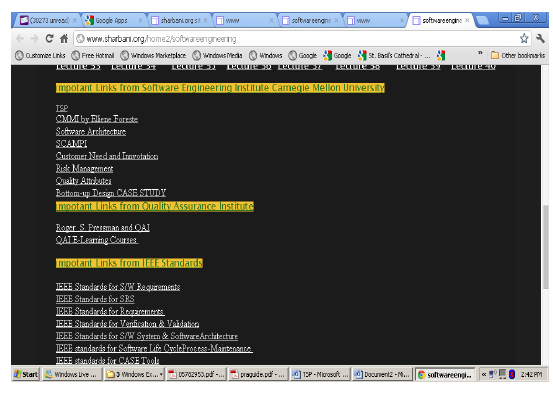
Figure 2. Links to SEI CMU, QAI and IEEE Standards